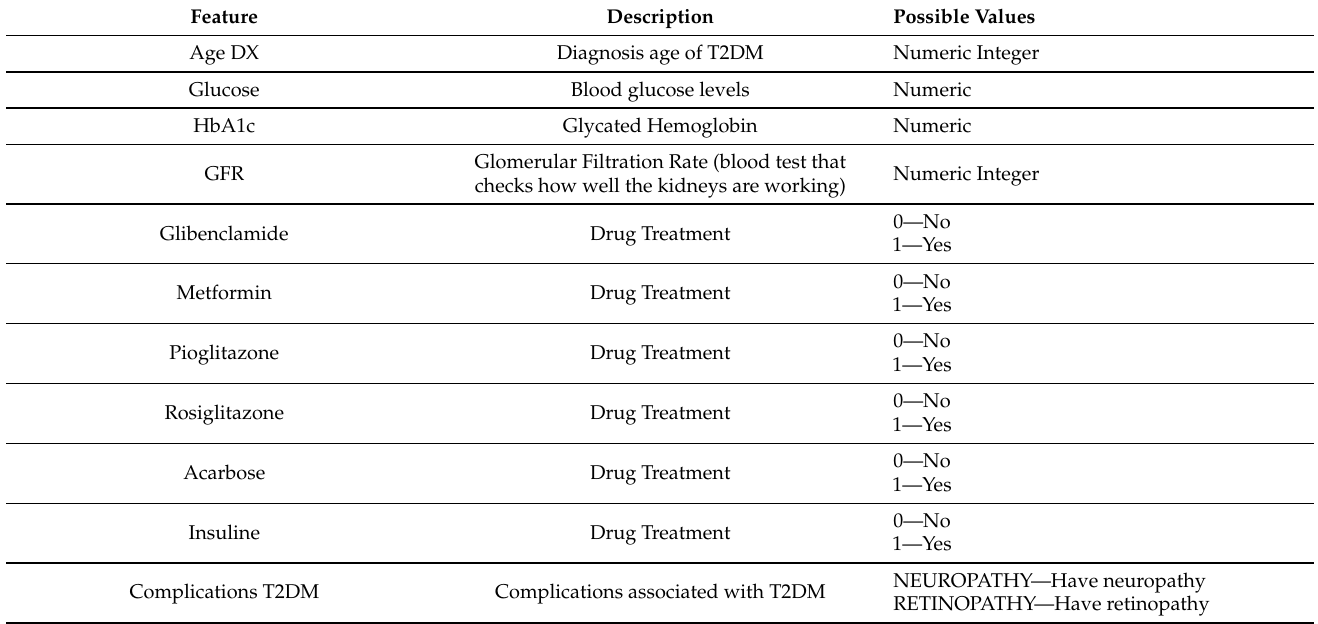
Table 1. Features